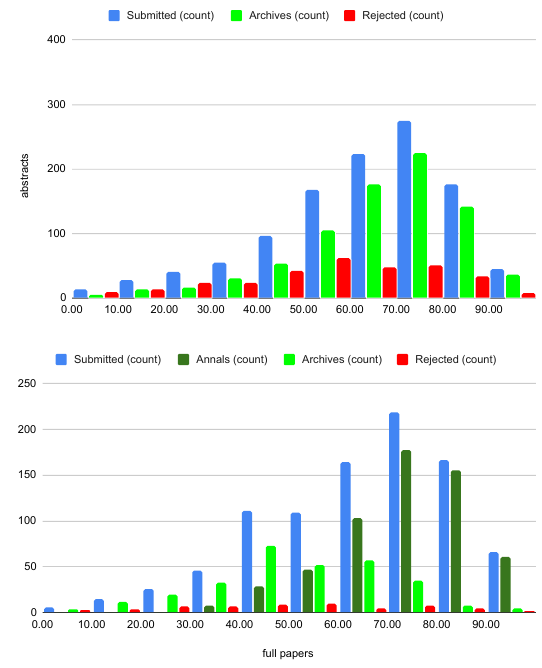
Figure 3. Review scores for abstracts (top) and full papers (bottom) according to their acceptance status. Rejected papers also include withdrawn contributions.